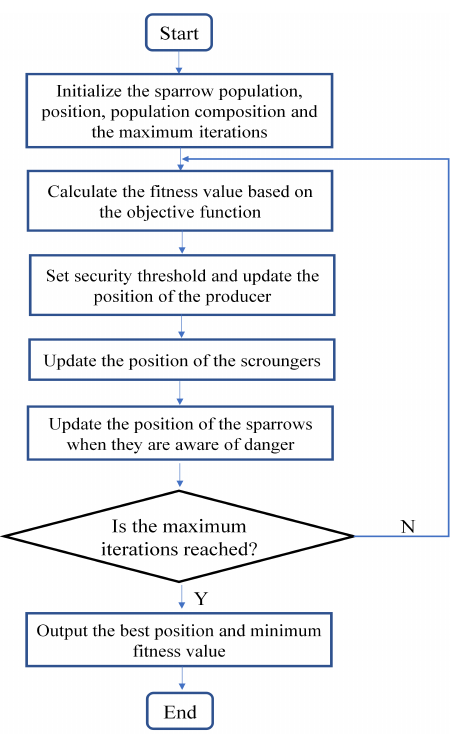
Figure 9. Program flow chart of